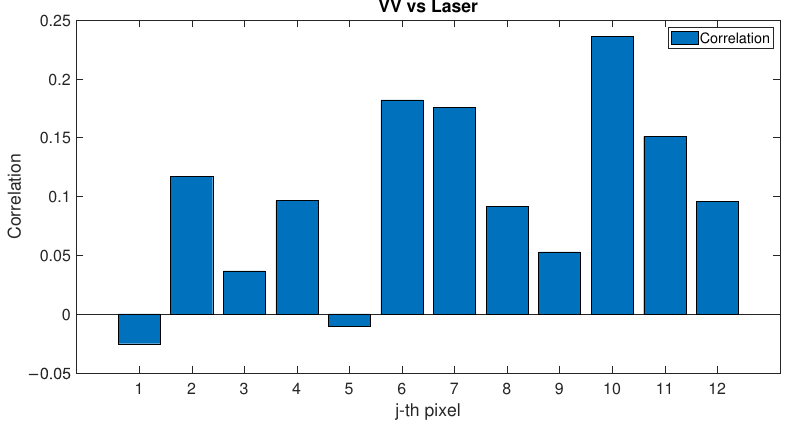
Figure 8. Correlation factor between SAR (VV polarisation) backscatter and PLS intensity evaluated for each pixel of the study area.